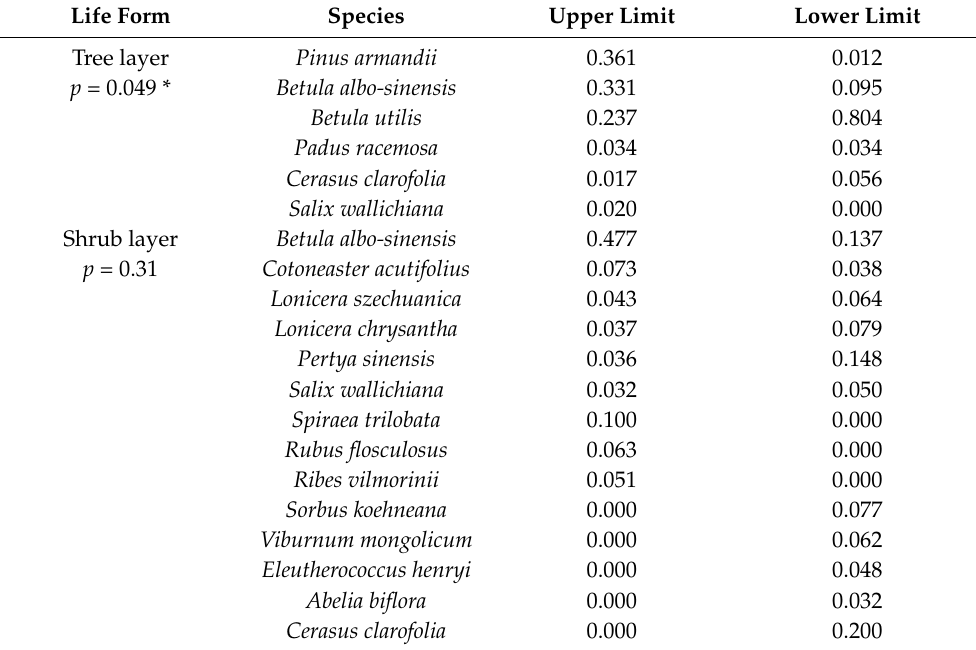
Table 2. Average importance values and PERMANOVA test on the similarity of community composi- tion in the tree layer and the shrub